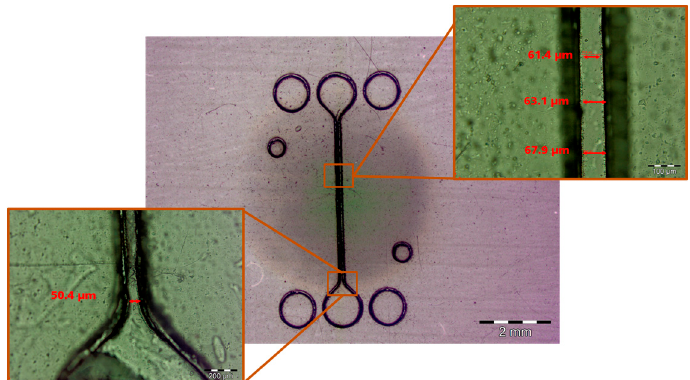
Figure 4. Microscope images of the first narrow channel fabricated via UV ps laser. The widths of the strip tape are ranging from 50 µm to 68 µm. This tape strip is removed before